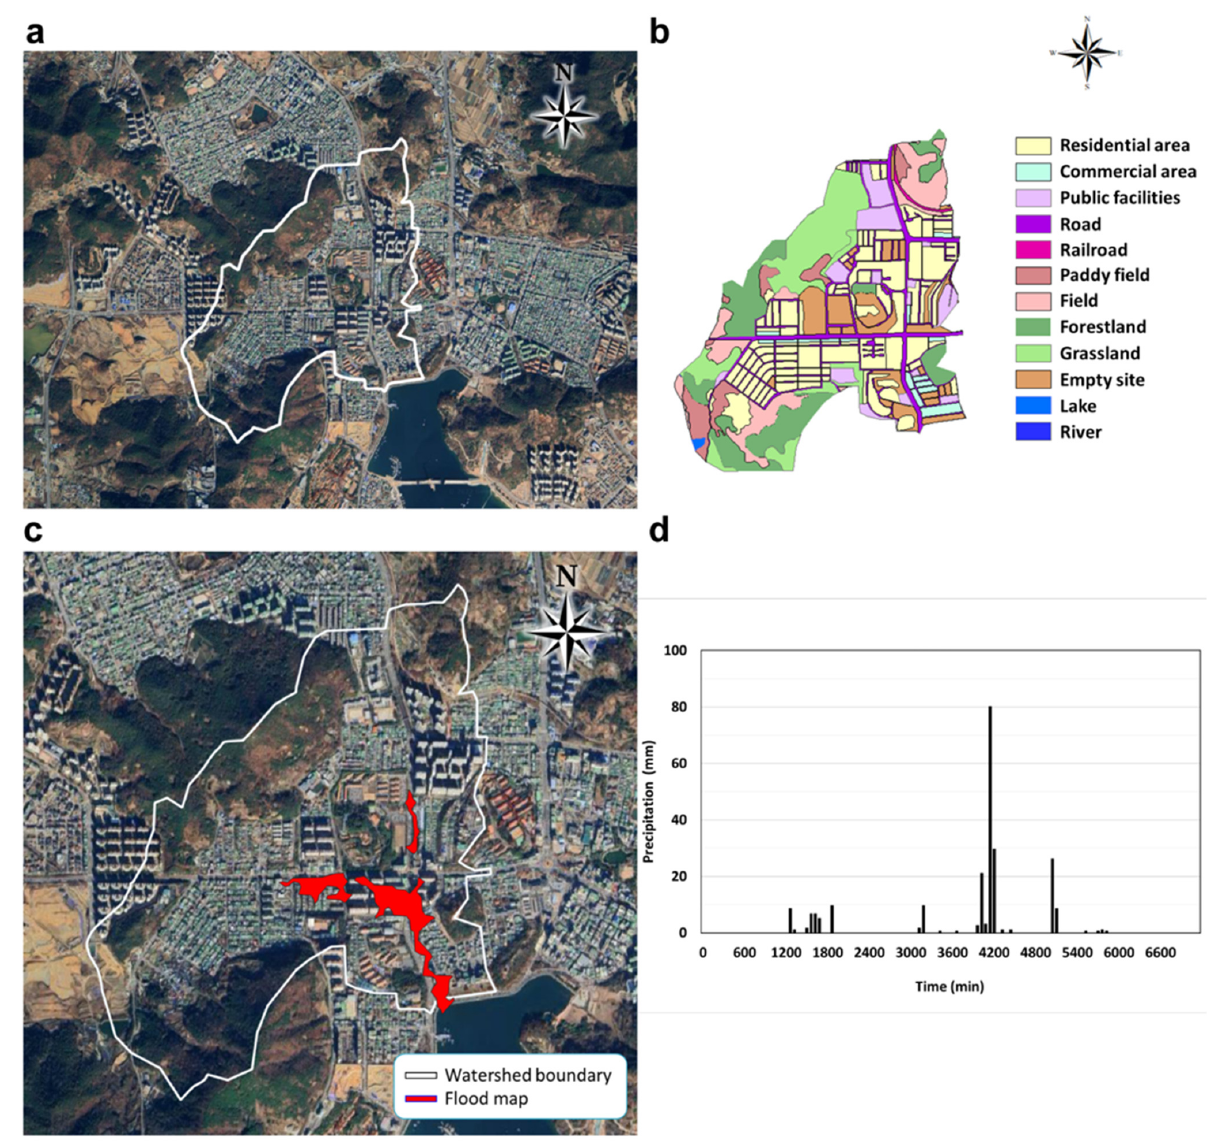
Figure 6. ( a ) Watershed boundary, ( b ) land use status, ( c ) flood damage history, and ( d ) damage- causing rainfall (19 to 23 August 2017) in the Dowon watershed, Yeosu.